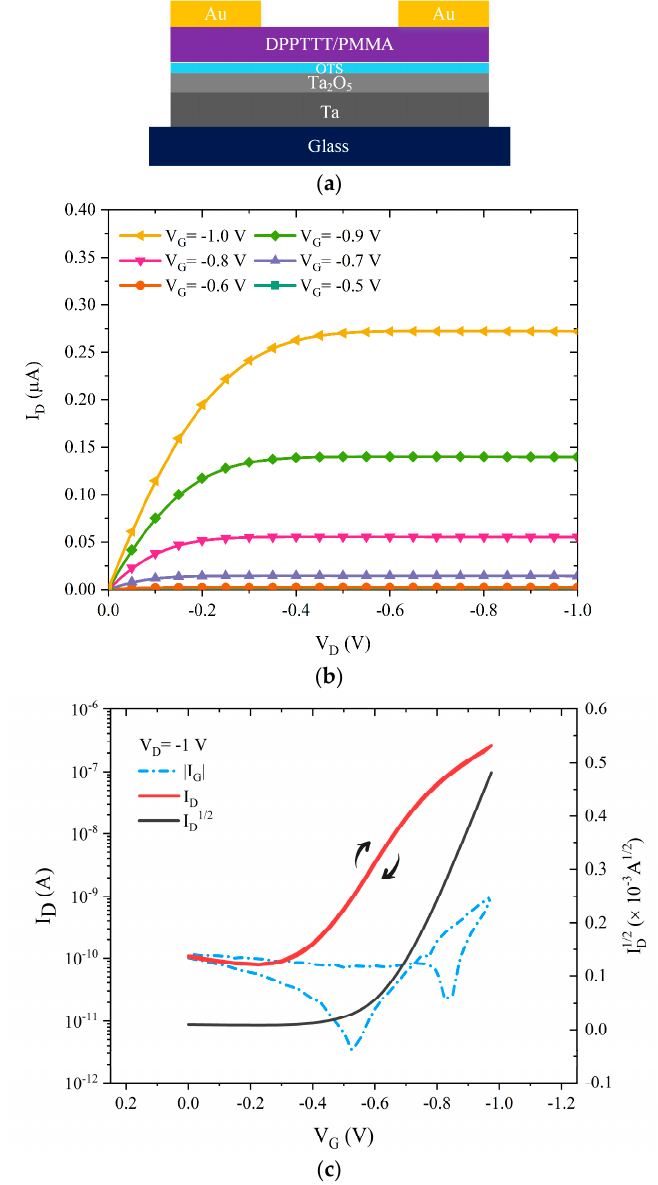
Figure 6. ( a ) Schematic structure of the OTFTs using OTS-modified Ta 2 O 5 anodized at V A = 3 V. ( b ) Output and ( c ) transfer characteristics of the fabricated OTFTs including I D , I D 1 / 2 and I G vs. V G at V D = − 1 V,